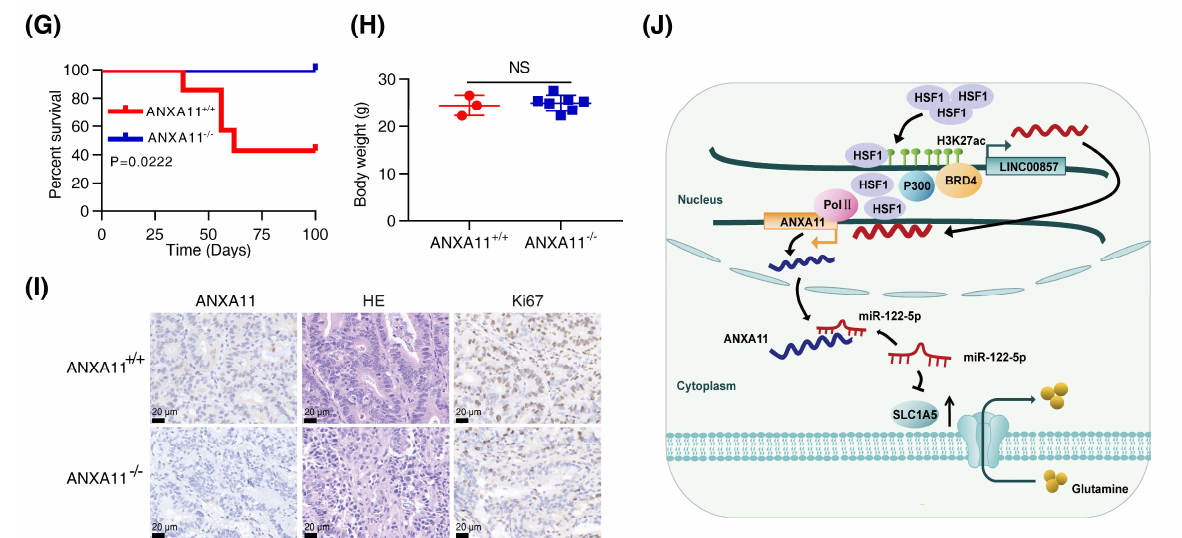
Figure 7. Knockout of ANXA11 attenuated CRC carcinogenesis in vivo. ( A ) Expression of ANXA11 protein in azoxymethane (AOM)/dextran sulfate sodium (DSS)–treated mice compared with normal mice. ( B ) Expression of ANXA11 protein in AOM/DSS–treated mice after HSF1 knockout. ( C ) Schematic digraphs depicting the CRISPR/Cas9-mediated ANXA11 knockout strategy. ( D ) Representative images of ANXA11 +/+ and ANXA11 −/− mice colon and rectum. ( E ) Assessment of the number of tumors of ANXA11 +/+ and ANXA11 − / − mice. ( F ) Assessment of the tumor area of ANXA11 +/+ and ANXA11 − / − mice. ( G ) The overall survival of ANXA11 +/+ and ANXA11 − / − mice. ( H ) The body weight of ANXA11 +/+ and ANXA11 − / − mice. ( I ) Representative HE (hematoxylin–eosin) staining and IHC (immunohistochemistry) staining of Ki67 and ANXA11 from the ANXA11 +/+ and ANXA11 − / − mice colorectal tissues (scale bar, 20 µ m). ( J ) Working model. All data represent the mean ± SD, n ≥ 3. **** p < 0.0001.